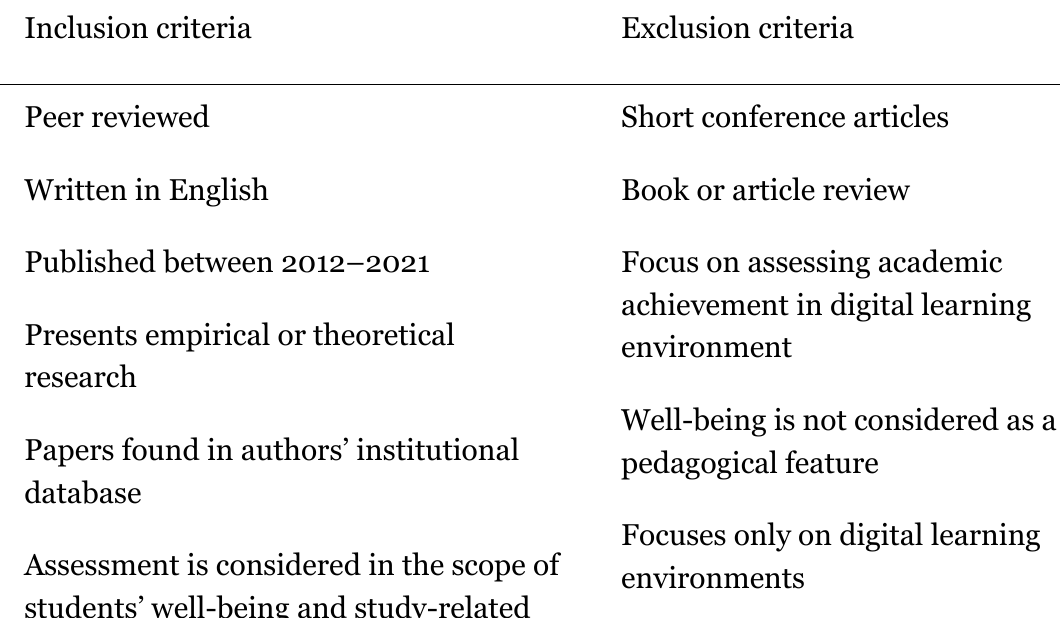
Inclusion and Exclusion